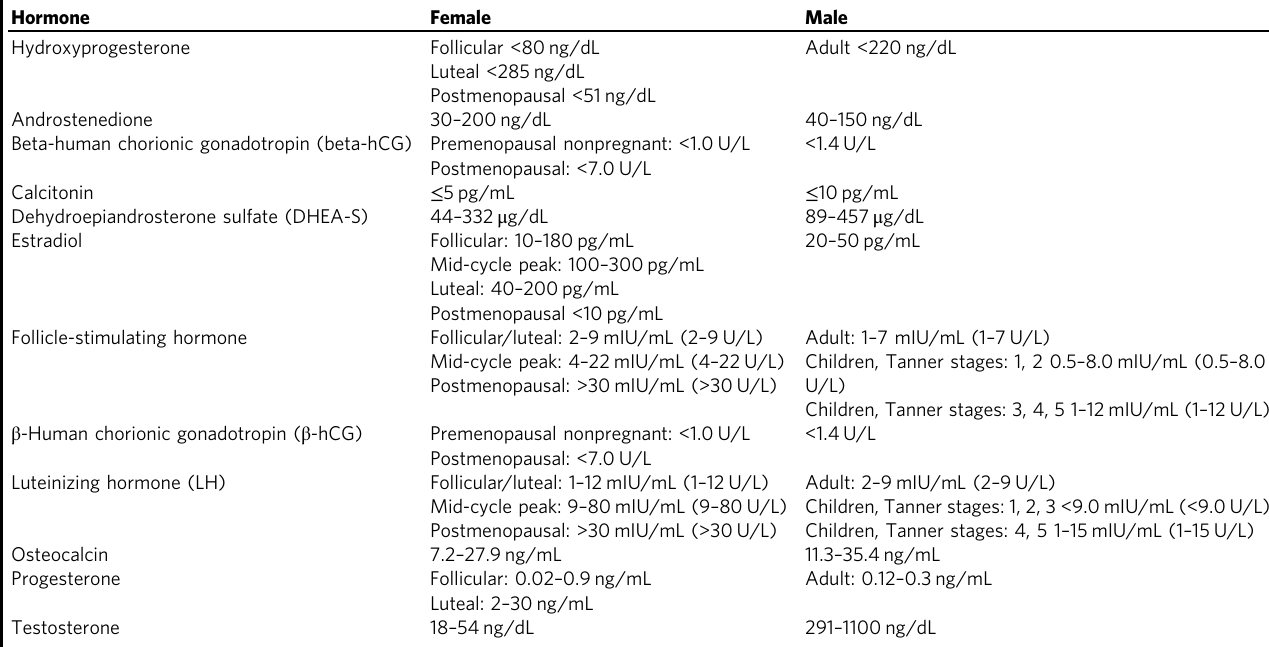
Table 1 Summary of normal hormonal changes in males and females ’ serum under different physiological conditions (data extracted from references 126 – 130